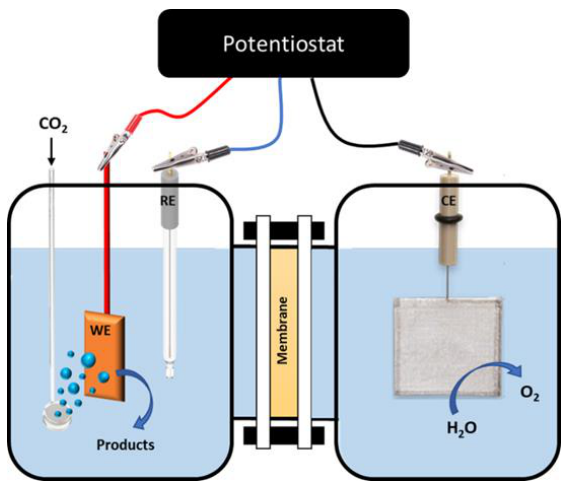
Figure 4. Schematic diagram of a conventional H-type electrochemical cell. CO 2 gas is bubbled in the catholyte using a glass frit. CO 2 is reduced on the working electrode (WE). A reference electrode (RE) is placed in the cathodic compartment, while the counter electrode (CE), usually a platinum mesh, is located in the anodic compartment. The two compartments are separated by an ion-exchange membrane.